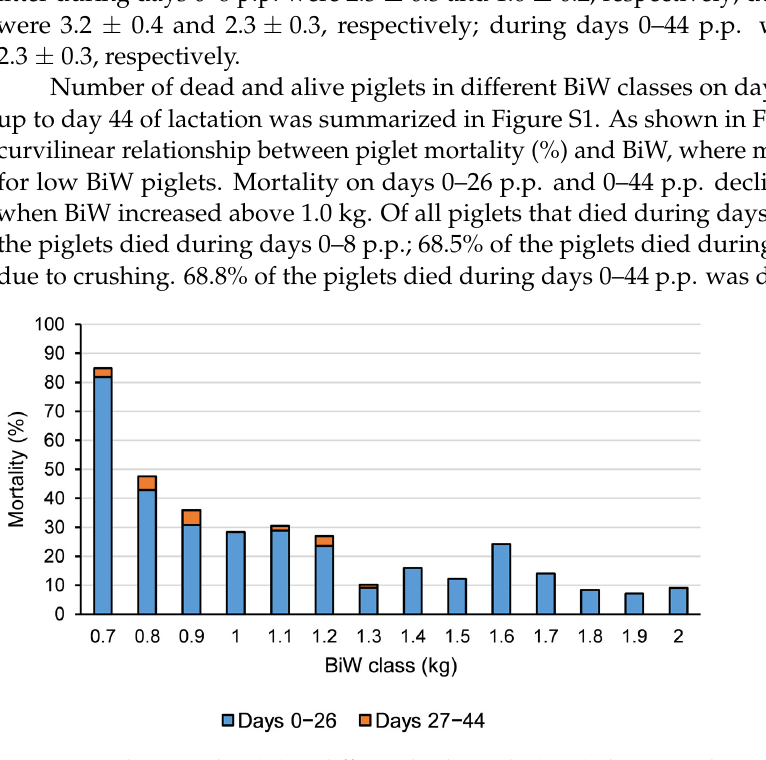
Figure 3. Piglet mortality (%) in different birthweight (BiW) classes on days 0–26 postpartum (p.p.) and 27–44 p.p. in all piglets up to day 44 of lactation in the multi-suckling (MS) system. Piglet mor- tality was calculated as the number of dead piglets divided by the number of both dead and alive piglets within BiW class. Piglets with BiW <0.7 and >2.0 kg are included in the 0.7 and 2.0 kg BiW class, respectively. Stillborn piglets were excluded from the data set and piglets which were cross- fostered in the MS system were included in the data set. Data were merged from two animal exper- iments conducted in the MS system. In exp 1, piglets were grouped on days 8–9 p.p. In exp 2, piglets in control groups were grouped on days 8–9 p.p. and no split-weaning was applied; piglets in treat- ment groups were grouped on days 13–14 p.p. and the three heaviest non-focal piglets per litter were split-weaned on day 35 p.p. Previously we found no treatment effect on most of the measured variables of piglets in exp 2. 3.2. Birthweight and Piglet Traits As shown in Table 1, in all piglets, BiW (kg) was positively related to BW gain (g/day) during days 0–27 p.p. ( β BiW = 102 g/kg of BiW per day, p < 0.001), 27–44 p.p. ( β BiW = 110 g/kg of BiW per day, p < 0.001) and 0–44 p.p. ( β BiW = 102 g/kg of BiW per day, p < 0.001). Like- wise, in focal piglets, BiW was positively related to BW gain on days 0–27 p.p. ( β BiW = 85 g/kg of BiW per day, p <0.001), 27–44 p.p. ( β BiW = 103 g/kg of BiW per day, p < 0.001) and 0–44 p.p. ( β BiW = 91 g/kg of BiW per day, p < 0.001), and this relation was similar for both sexes. Other parameters were available for focal piglets only. During days 42–43 p.p., BiW tended to be positively related to DM intake of sow feed ( β BiW = 44 g/kg of BiW per day, p = 0.065) and milk intake ( β BiW = 102 g/kg of BiW per day, p < 0.001). Birthweight was not related to DM intake of piglet feed, DM intake of total feed, the percentage of time spent on contacting feed during sow feeding times on days 40–43 p.p., or contacting total feed during the day on day 41 p.p. Both the percentage of time spent on contacting sow feed during the day and piglet feed during the day on day 41 p.p. were affected by BiW in gilts ( β BiW = 4.6%/kg of BiW, p = 0.038 and β BiW = − 3.4%/kg of BiW, p = 0.081, respectively) (inter- action effect: p = 0.041 and p =0.055, respectively), but not in boars. Birthweight was posi- tively related to the frequency of presence at the front and middle teats ( β BiW = 2.3 no./kg of BiW per 7.5 h, p = 0.009) and total teats on day 41 p.p. ( β BiW = 2.8 no./kg of BiW per 7.5 h, p < 0.001), but it was not related with the frequency of presence at rear teats or alien teats. Birthweight was positively related with skin lesions on day 27 p.p. ( β BiW = 4.3 no./kg of BiW, p = 0.012).